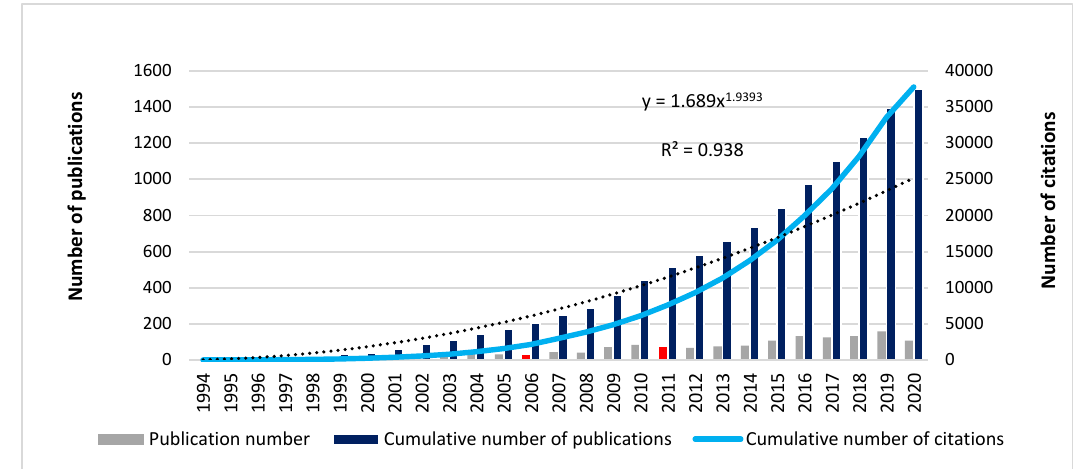
Figure 2. Diachronic productivity of the research.